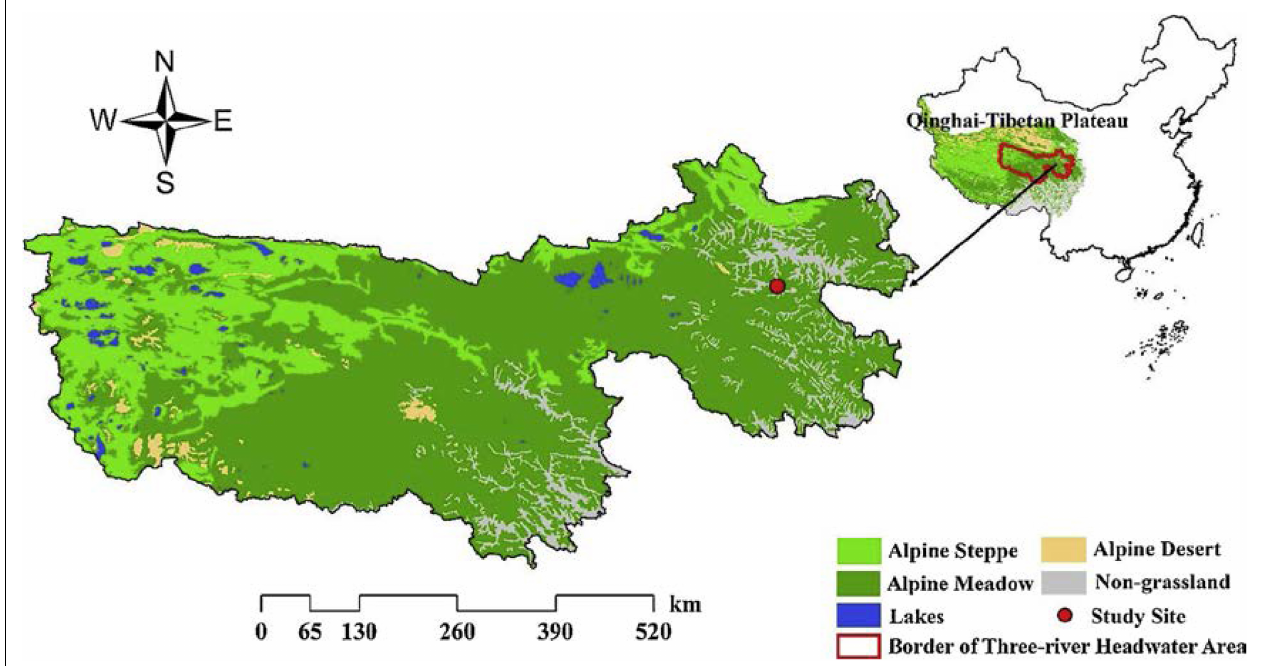
FIGURE 1 | Distribution of the study sites in the three river headwater area of Qinghai–Tibetan Plateau (Gao et al.,